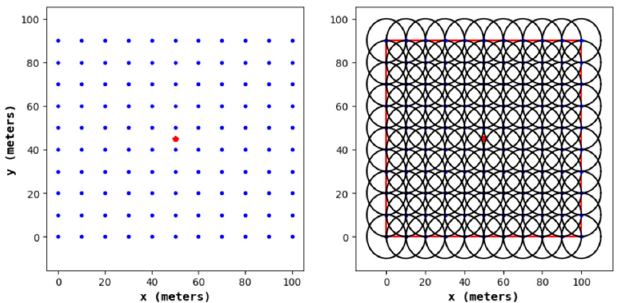
Figure 13. The node distribution diagram of the 1-fold coverage-based node deployment strategy in a cellular network.